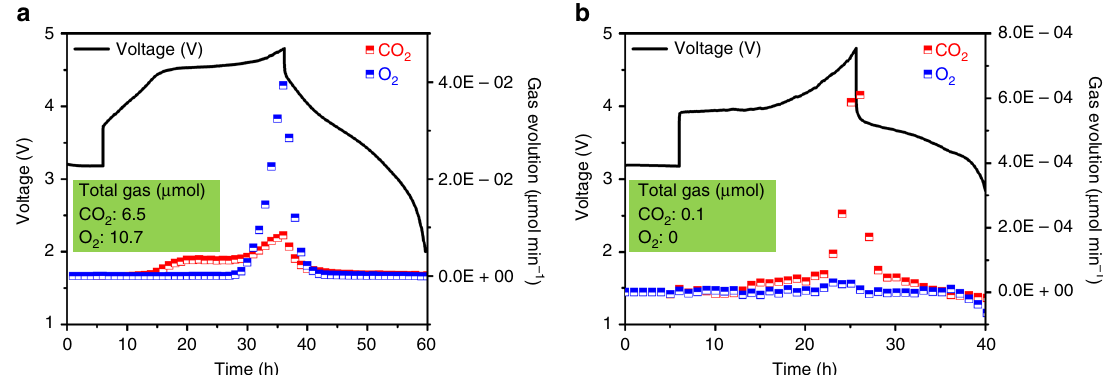
Fig. 3 Gas evolution of LNMO and LNRO by operando DEMS. The fi rst cycle voltage pro fi les and gas evolution rates of a LNMO and b LNRO. The total active cathode material used for the measurement was 32.9 mg LNMO (387 μ mol) and 28.6 mg LNRO (253 μ mol). Cells were cycled between 4.8 and 2.0 V, at a current of 10 mA g – 1